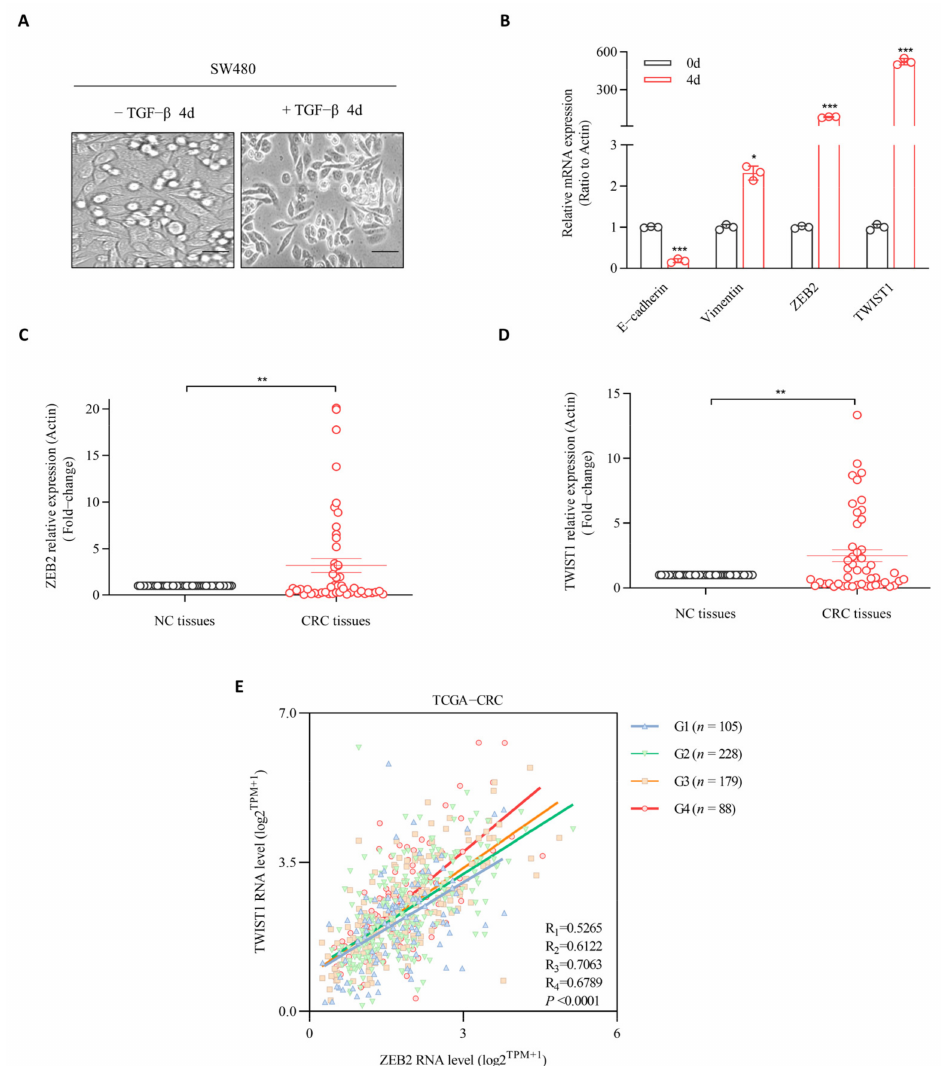
Figure 1. ZEB2 and TWIST1 are both remarkably upregulated during TGF- β -induced EMT in CRC cells and patient tissues. ( A ) Colon cancer cell line SW480 was treated with TGF- β 1 (15 ng/mL) for 4 days; morphological changes were taken at × 10 magnification. Scale bars, 50 µ m. ( B ) Relative mRNA levels analyses are shown as means ± SD. * p ≤ 0.05; *** p ≤ 0.001. ( C , D ) Expression levels of ZEB2 and TWIST1 in colon carcinoma in 49 paired CRC and NC tissues by qRT-PCR analysis. Results represent mean ± SD; ** p ≤ 0.01. ( E ) The positive correlation between expression of ZEB2 and TWIST1 target genes involved in various biological outcomes in